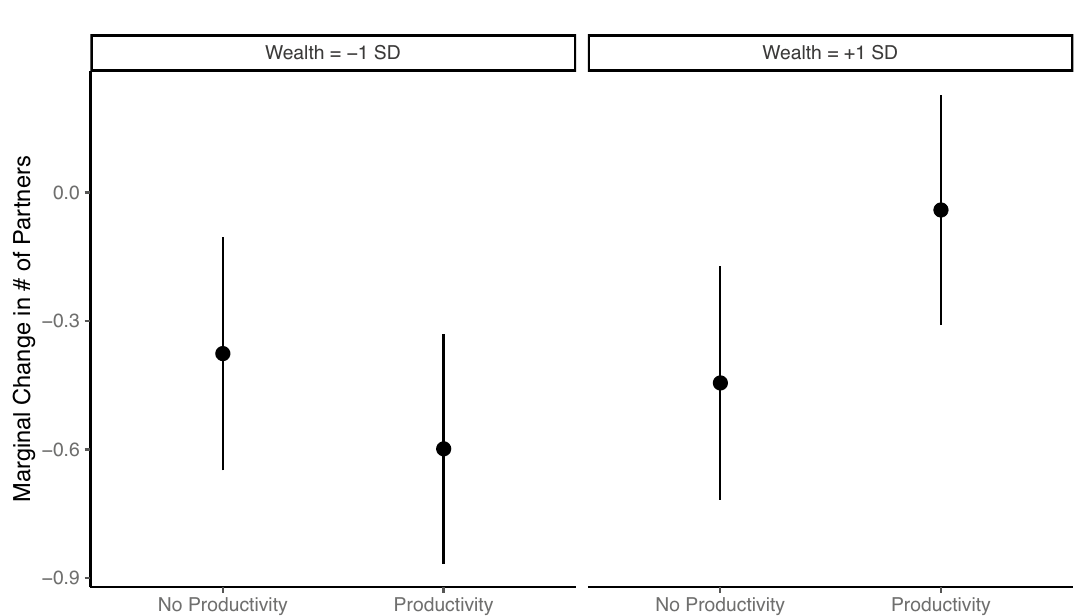
Figure 6. Cumulative ( A ) tie updates and ( B ) network isolates by experimental condition through time.